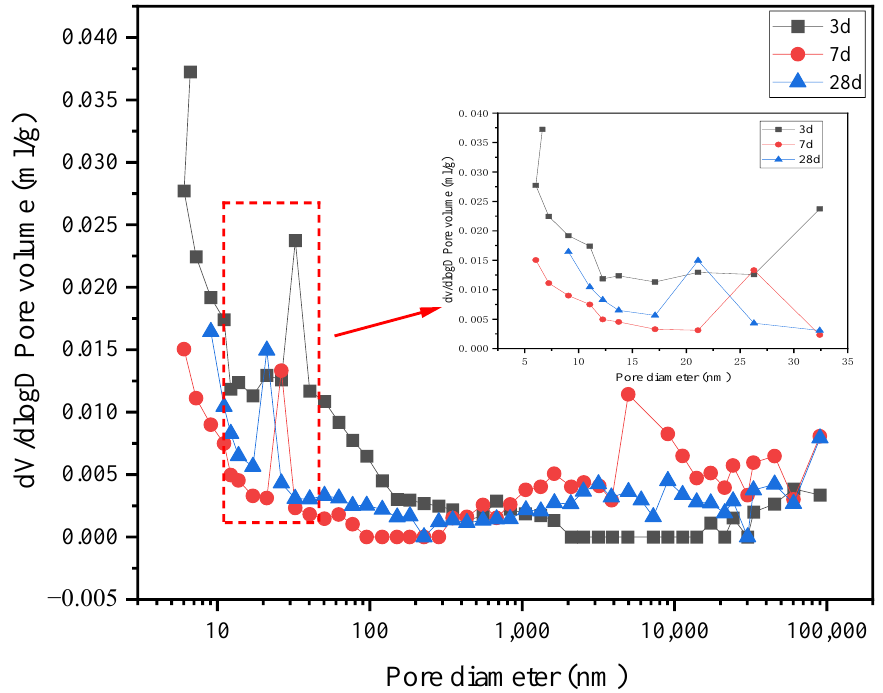
Figure 11. Differential curve of the pore size distribution of the G1 paste.